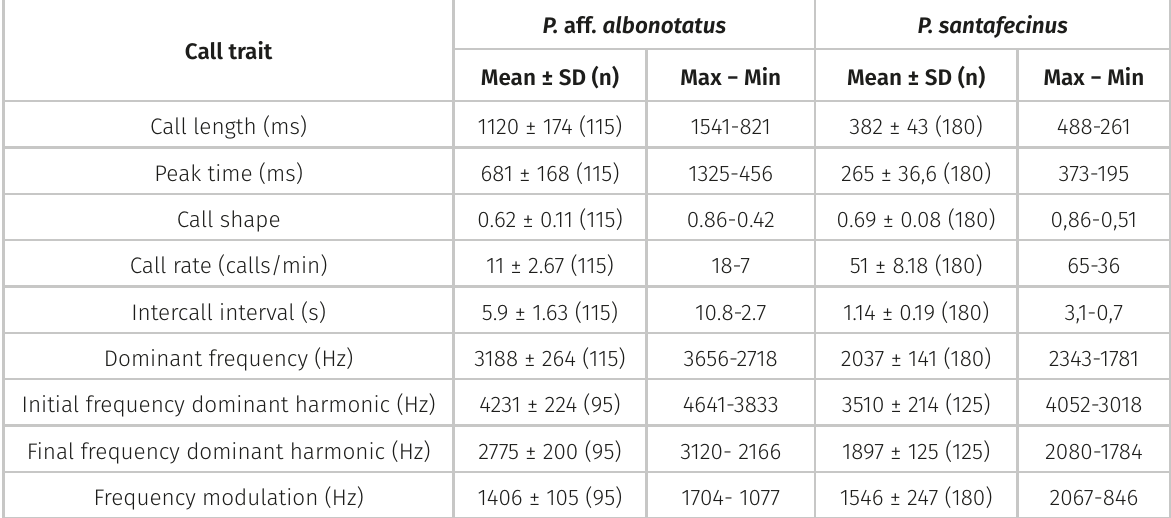
Table I. Mean, standard deviation, and maximum and minimum values of P. aff. albonotatus and P. santafecinus call traits, (n) sample